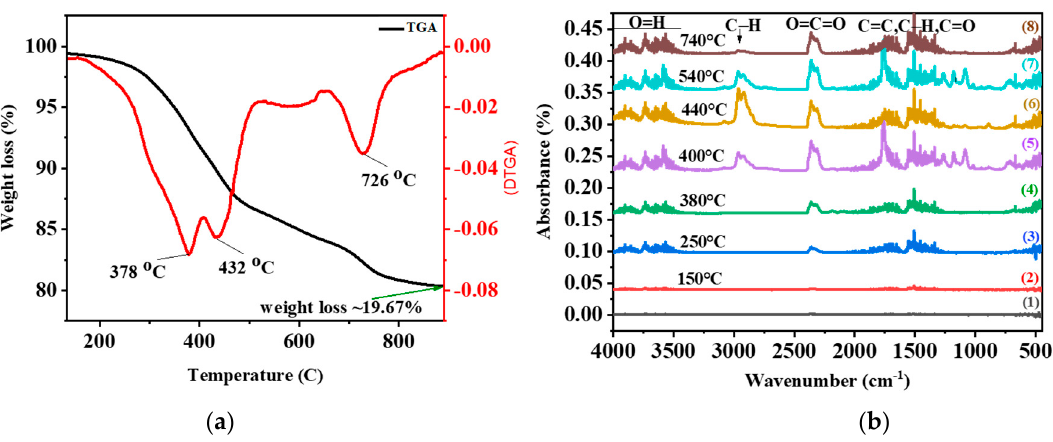
Figure 2. ( a ) TGA and DTGA curves of mixed 50–50% the ASR plastics and glass, ( b ) FTIR analysis of mixed powder of the mixed plastics of ASR and glass at different periods ( 1 ) 3 min, ( 2 ) 5 min, ( 3 ) 10 min, ( 4 ) 15 min, ( 5 ) 22 min, ( 6 ) 25 min, ( 7 ) 30 min and ( 8 ) 40 min.